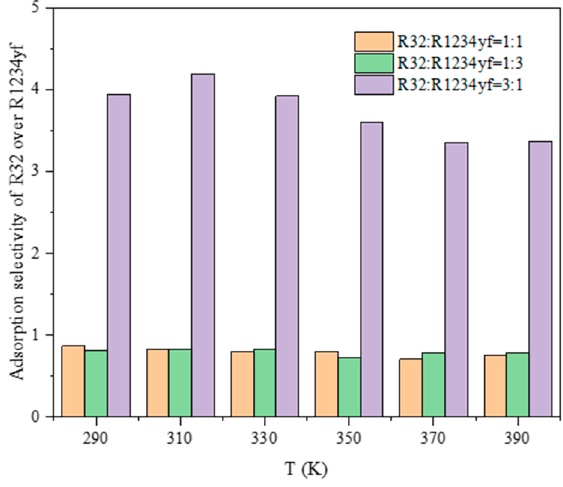
Figure 3. Adsorption selectivity of R32 over R1234yf at different systems.